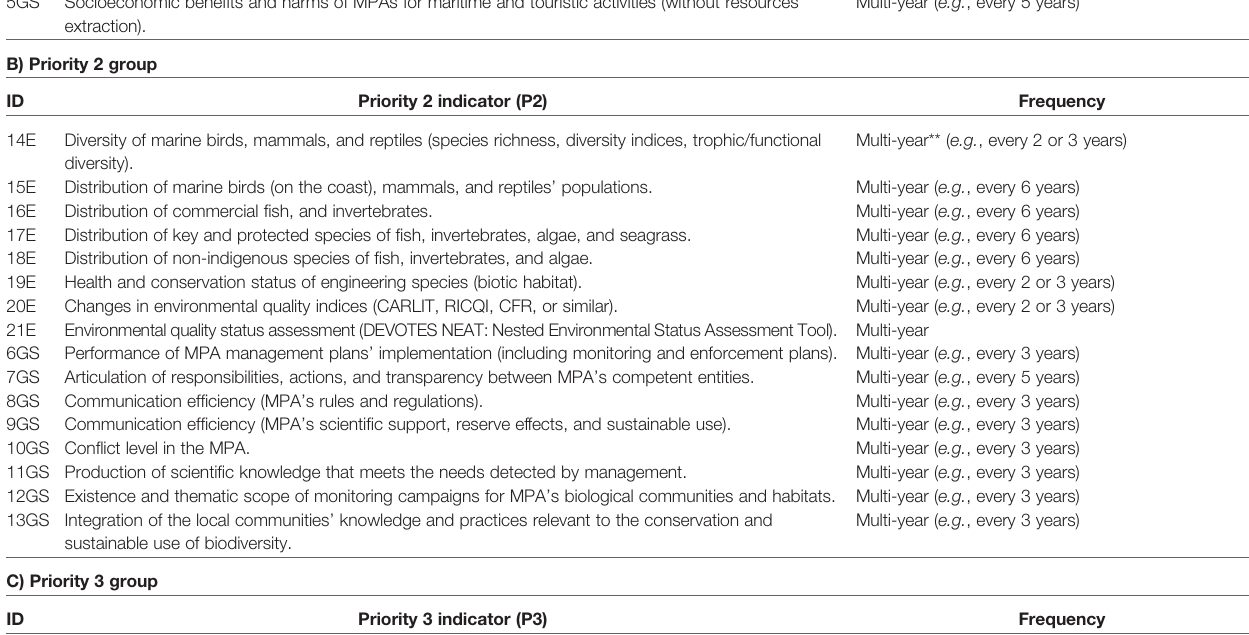
( Table 3 ). In Workshop III, participants widely accepted the priority groups (based on the relevance scores), with minor